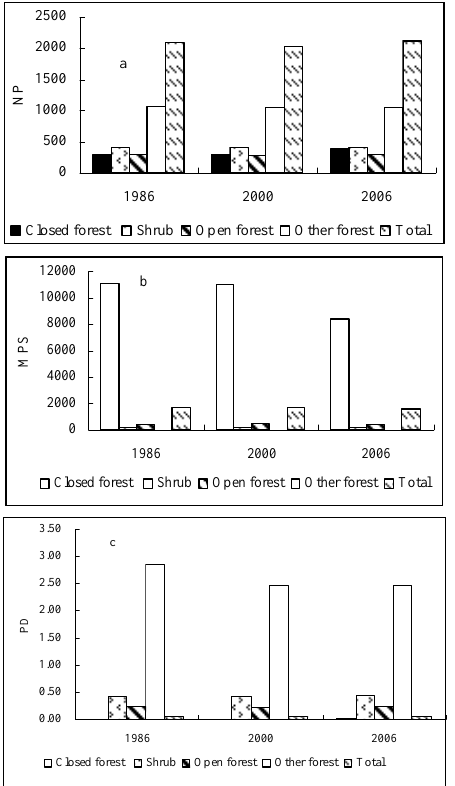
Figure 2. Forest in study area in 1986(a), 2000(b),